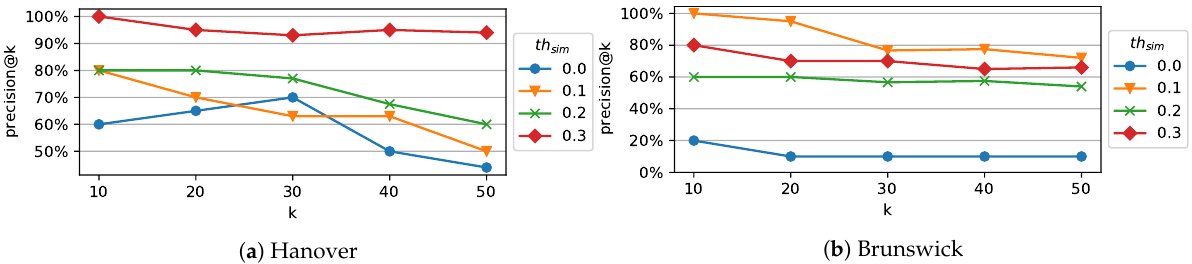
Figure 3. Precision@k with respect to k and th sim of the identified structural subgraph dependencies. The best precision at k=10 is achieved by th sim = 0.3 (Hanover) and th sim = 0.1 (Brunswick). This indicates that the optimal value of th sim is dependent on the target road network. In both cases, the worst performance is achieved at th sim = 0. The graph parti- tioning at th sim = 0 is relatively coarse such that units that exhibit different dependencies can be aggregated into the same subgraph. Therefore, the achieved performance is lower than for the higher threshold